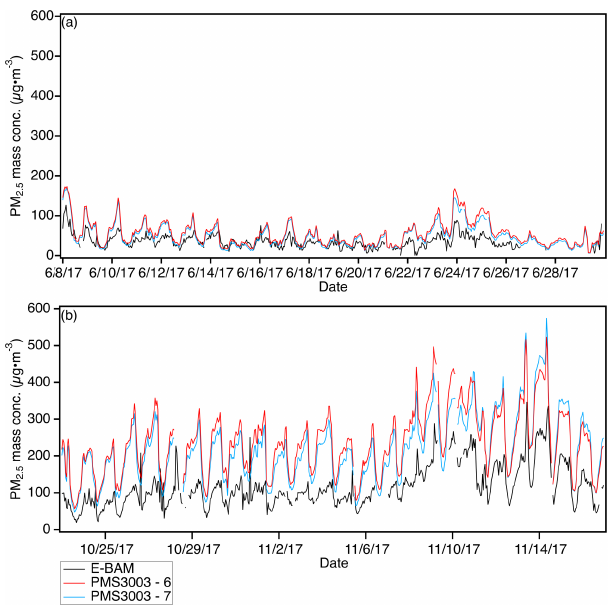
Figure 9. Comparison of hourly PM 2 . 5 mass concentrations be- tween the E-BAM and the two uncalibrated PMS3003 sensor pack- ages (a) from 8 to 29 June 2017 (monsoon season) and (b) from 23 October to 16 November 2017 (post-monsoon season) at IIT